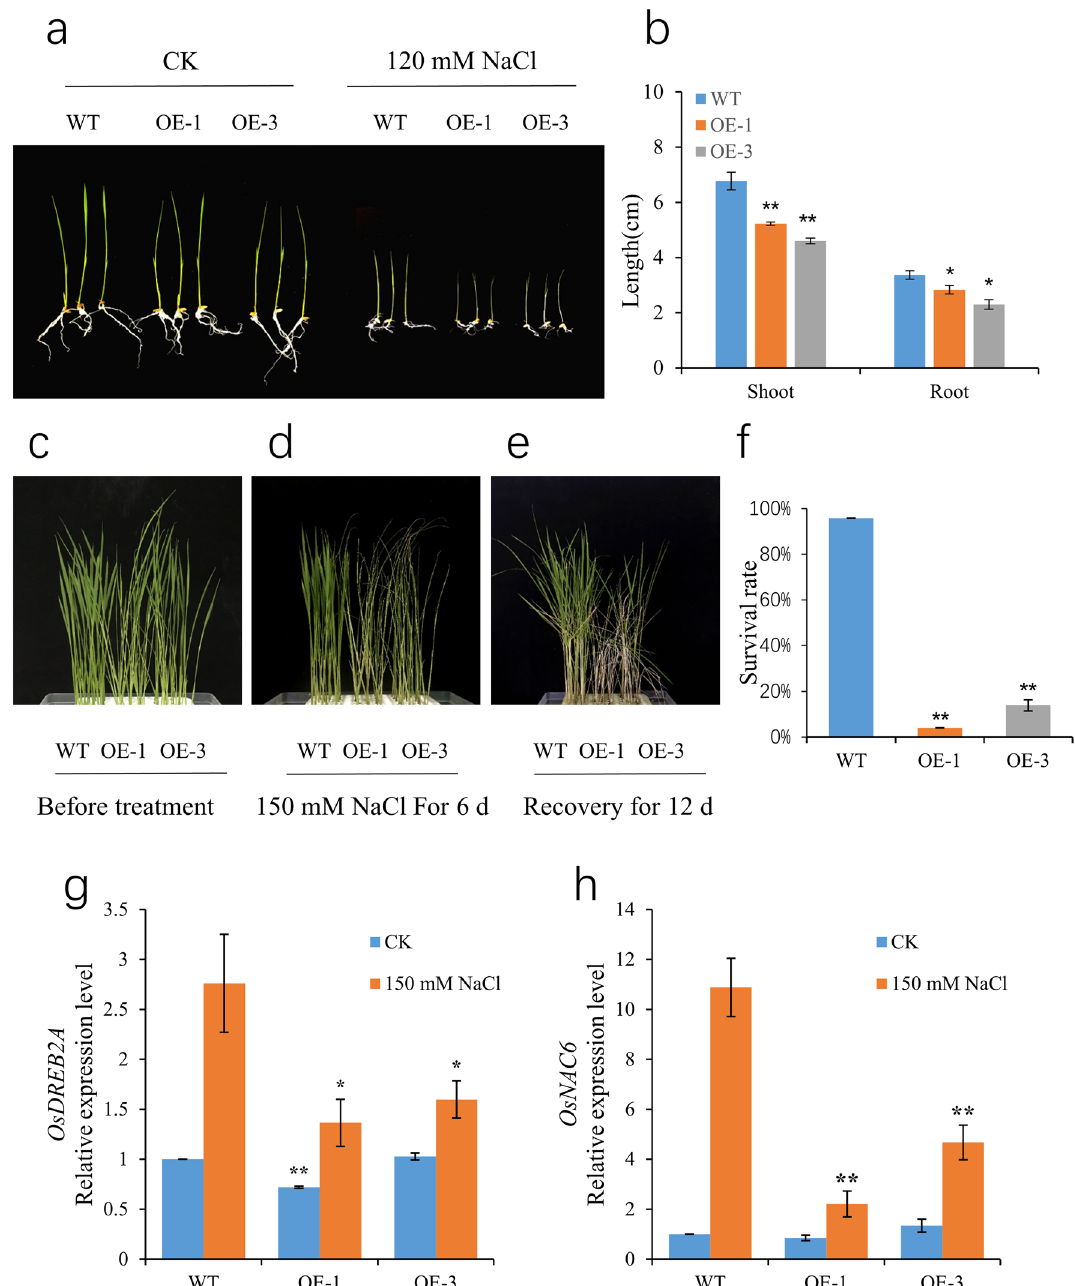
Figure 5. Effects of salt stress in wild type (WT) and OE lines. ( a ) Phenotypes of WT and OE lines under 120 mM NaCl for 3 days. ( b ) Plant height and root length of WT and OE lines treated at 120 mM NaCl for 3 days. ( c ) Phenotype of WT and OE lines hydroponically cultivated for 14 days (before imposition of the salt stress). ( d ) Phenotypes of WT and OE lines treated for 6 days at 150 mM NaCl. ( e ) Phenotypes of WT and OE lines after 12 days recovery following the 150 mM NaCl treatment. ( f ) Survival of recovered WT and OE lines. ( g – h ) The expression levels of OsDREB2A and OsNAC6 were analyzed after two days of treatment at 150 mM NaCl, respectively. Error bars represent ± SE (n = 3). Asterisks indicate significant differences between transgenic lines and WT ( * P < 0.05, ** P <